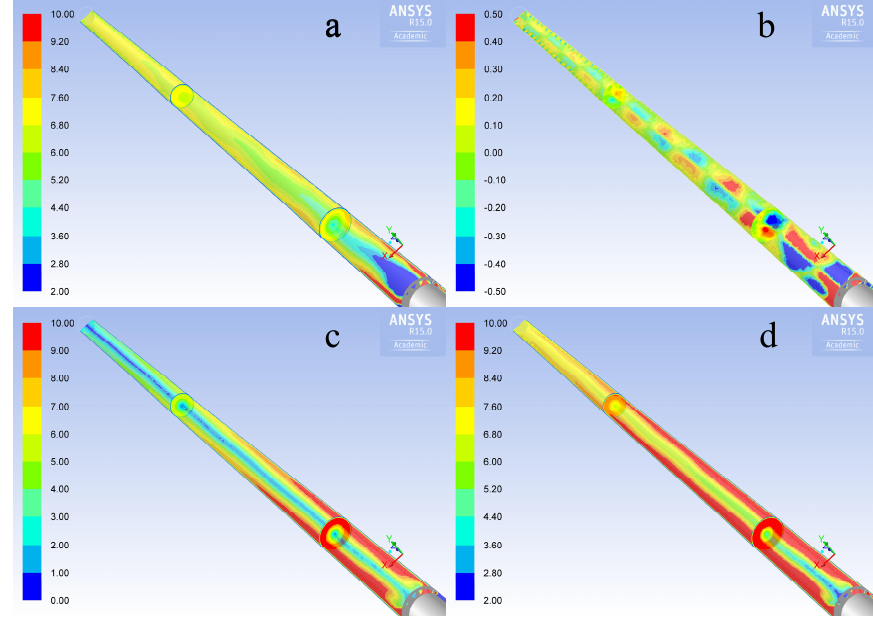
Figure 13. Simulated velocity field inside the stack simulator in all its components: ( a ) total, ( b ) axial, ( c ) radial and ( d ) tangential velocity. Units are m/s.